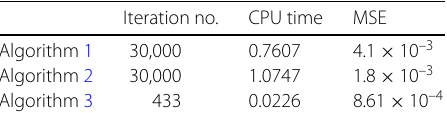
Table 3 Comparison of each algorithm